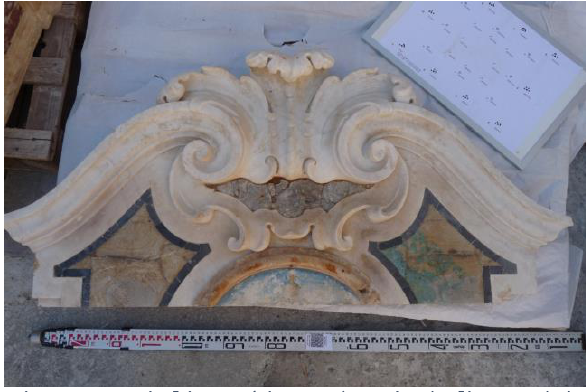
Figure 6. A typical image (piece #85). Notice the linear rod, the QR-Code with references and metadata and the calibrated grid.